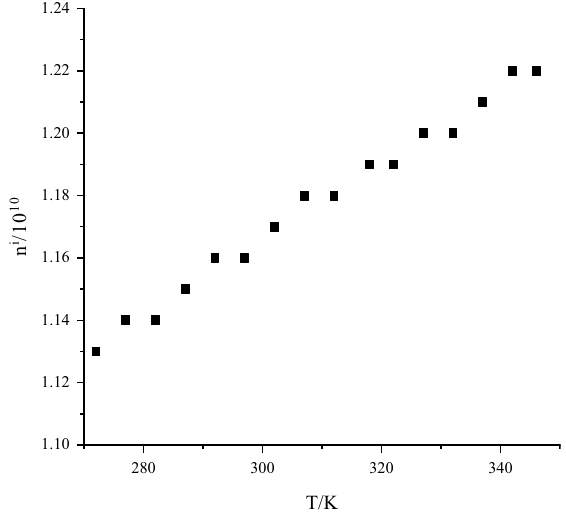
Figure 3: The in fl uence of temperature T on the number of carriers n i